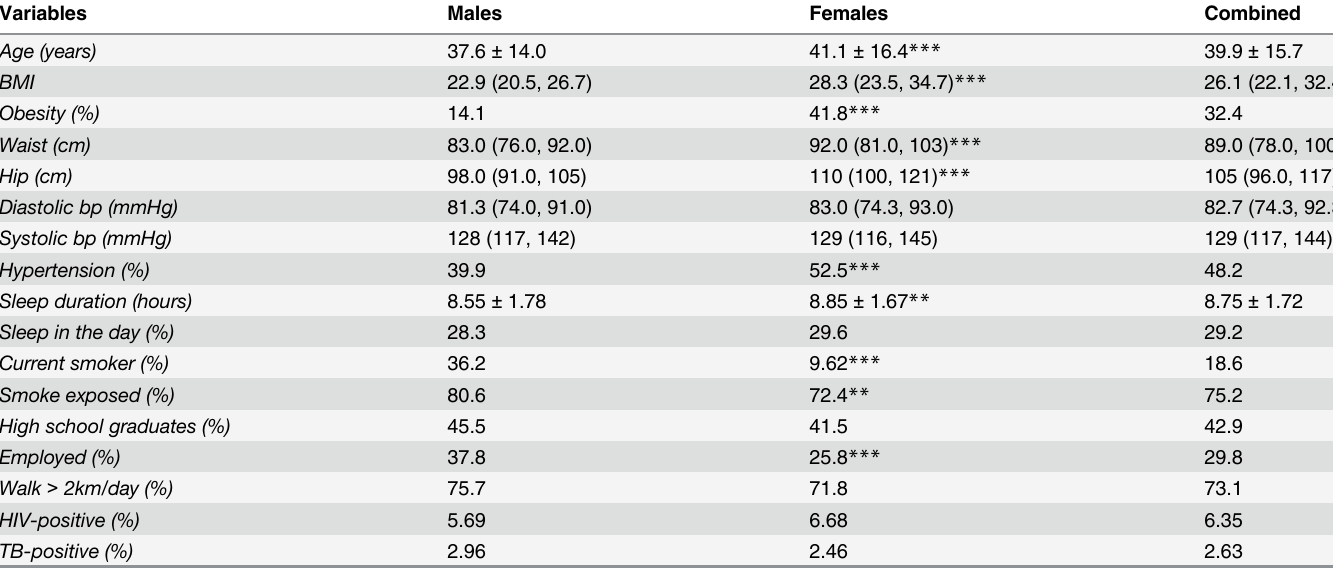
Table 1. Comparison of male and female